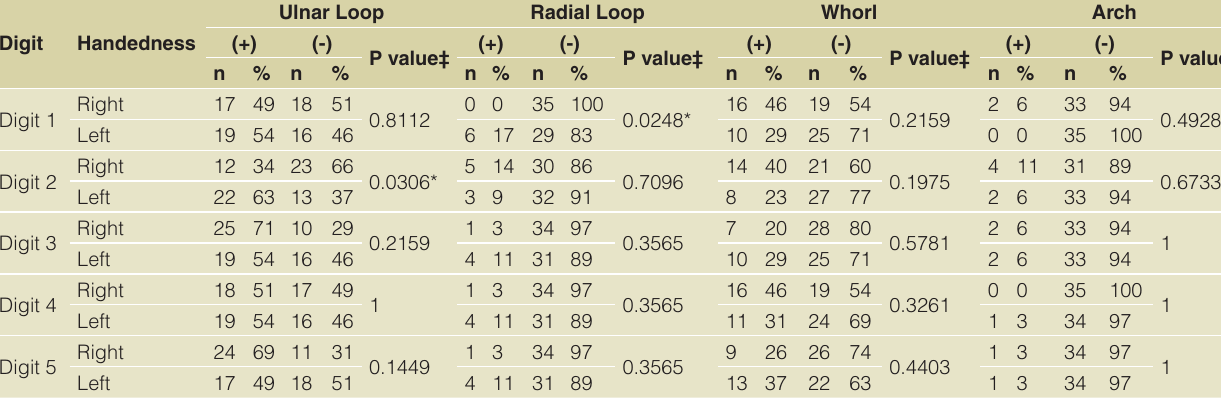
Table 2. Digital dermatoglyphic pattern distribution of left hand in females.